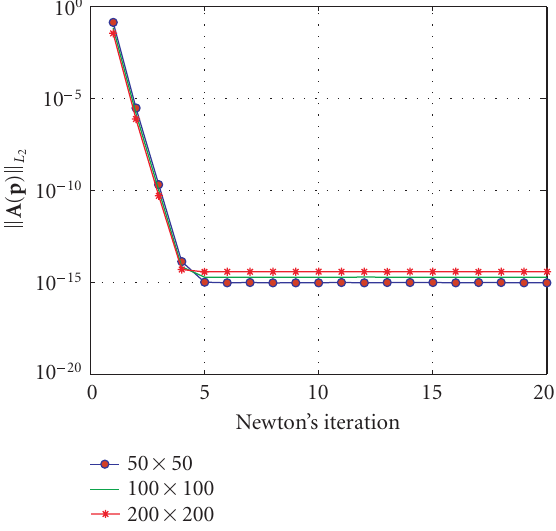
Figure 4.5 . Example 4.2: Newton’s iteration versus the residual norm (cid:4) A ( p ) (cid:4) L